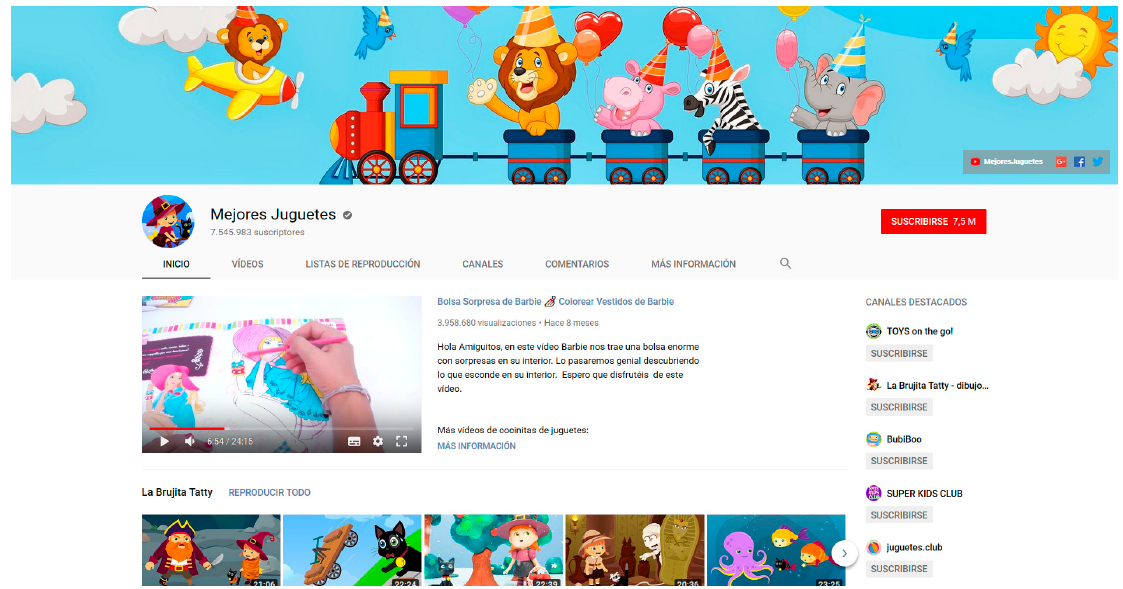
Figure 7. Front page of the YouTube channel VEGETTA777.